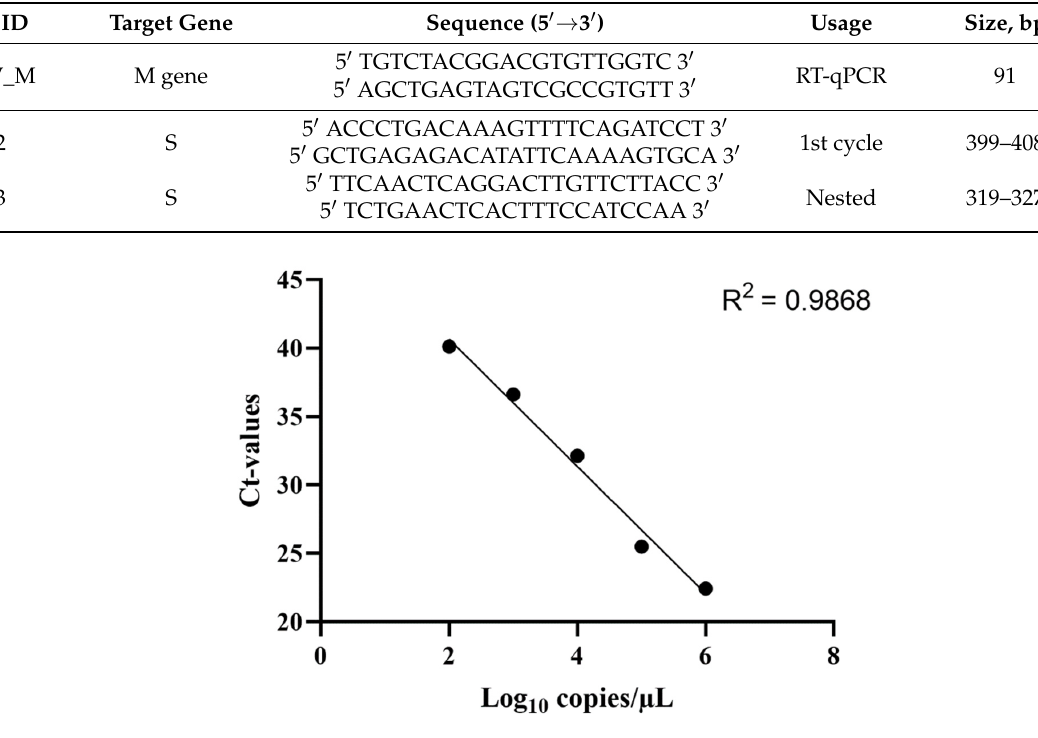
Table 1. Primers for the amplification of the PEDV M gene by using an RT-qPCR assay and primers for short nested RT-PCR to amplify the SARS-CoV-2 S partial gene in wastewater.